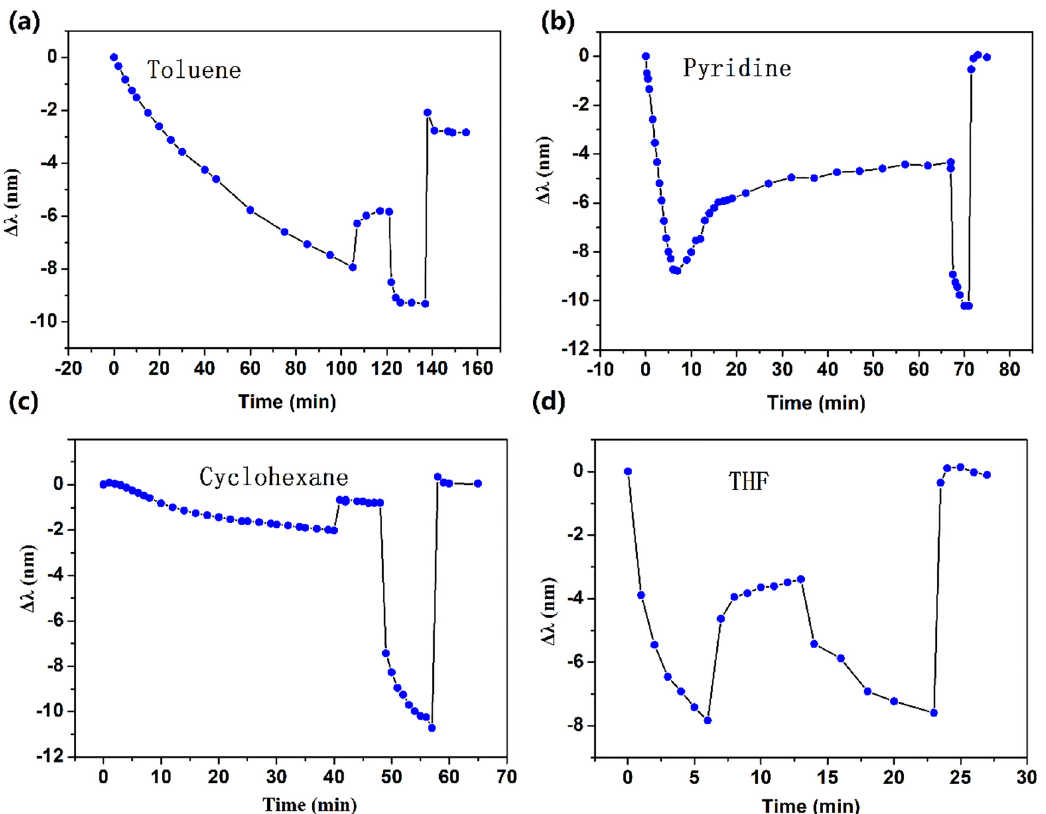
Figure 7: Dynamic wavelength changes of fiber Mach – Zehnder interferometer (MZI) during the